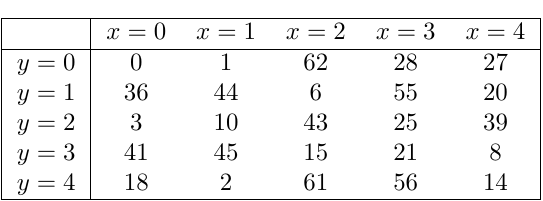
Table 2: The offsets of ρ